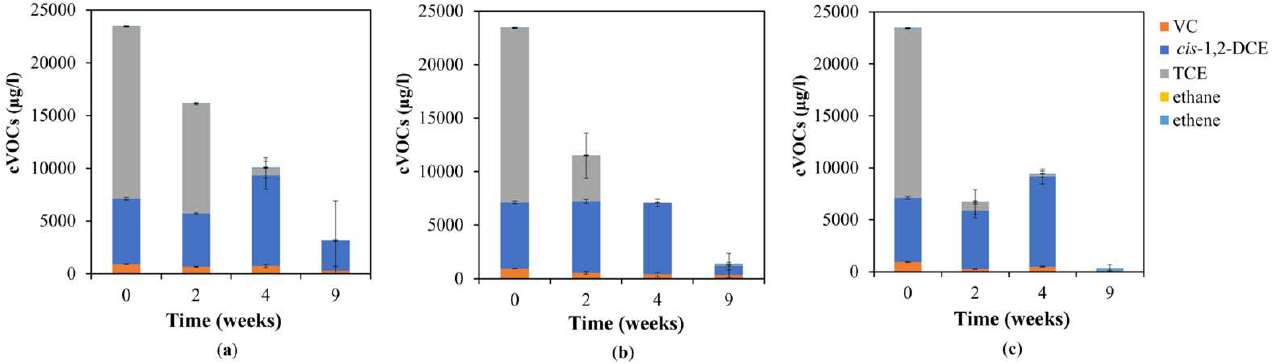
Figure 2. Individual concentrations of VC, cis -1,2,-DCE, TCE, and dechlorinated products (ethane and ethene) in the groundwater at different lab test temperatures of ( a ) 12 ◦ C, ( b ) 17 ◦ C, and ( c ) 22 ◦ C during the lab-scale test with whey